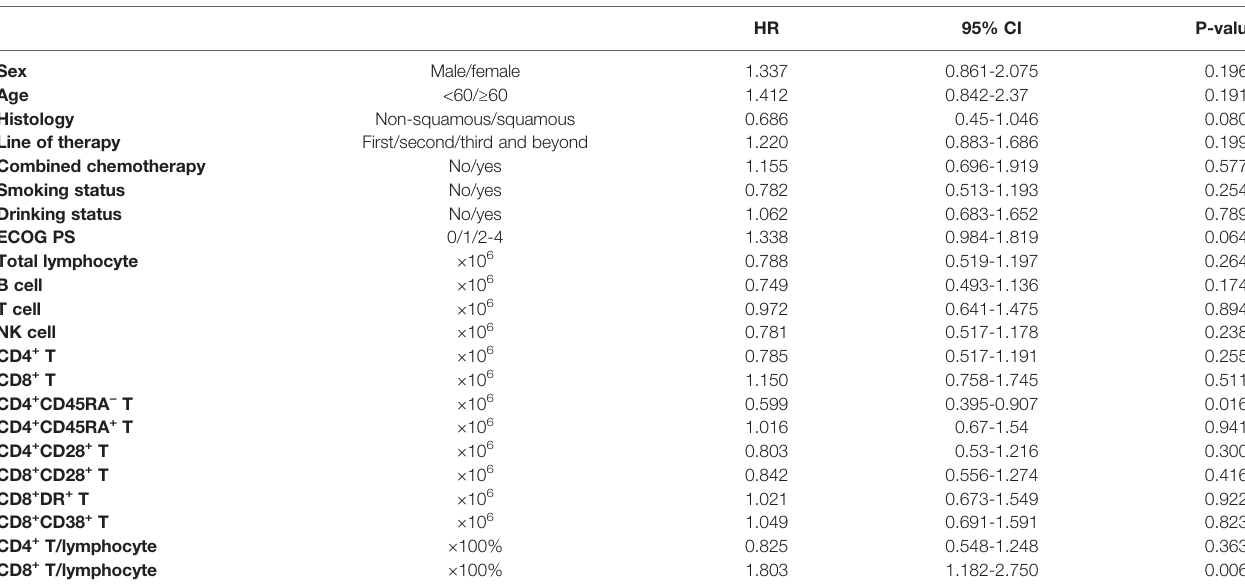
TABLE 2 | Univariate Cox regression of